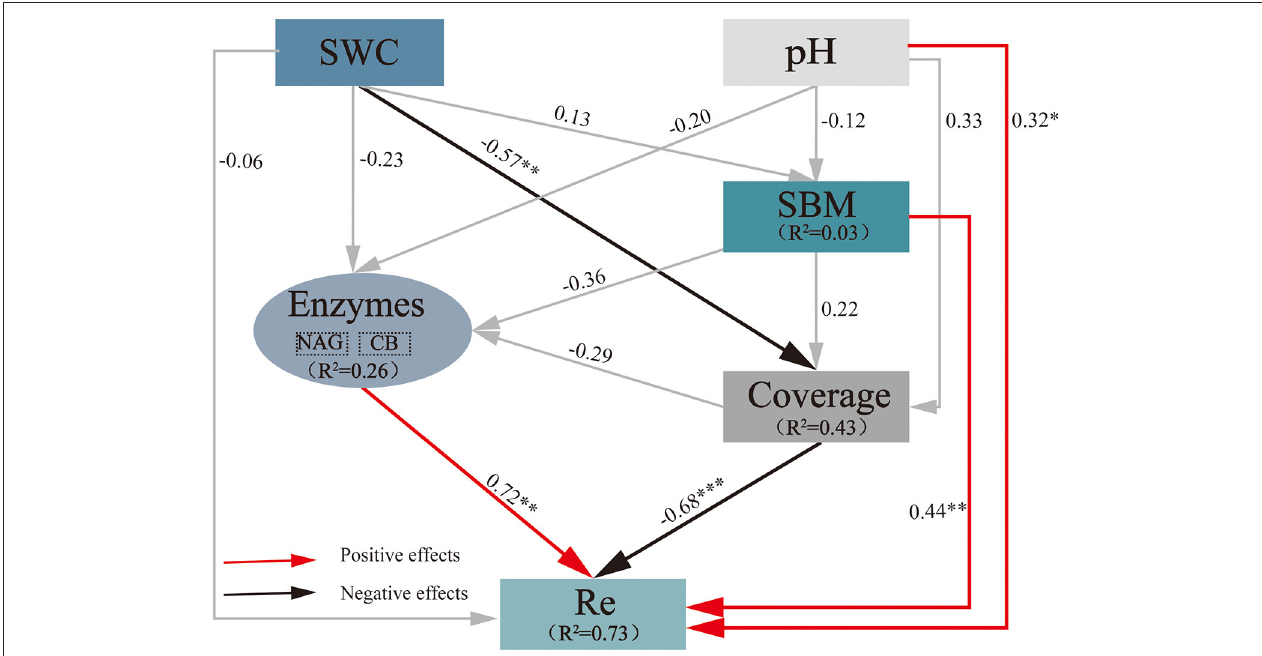
FIGURE 4 | Impacts of selected drivers on Re under extreme drought calculated by the SEM of path analysis based on data collected in 2019. The values on the arrows are normalized path coefficients, and the asterisks after the numbers indicate remarkable correlations (* p < 0.05, ** p < 0.01, and *** p < 0.001). The rectangle R 2 value represents the ratio of variance explained by relationships with other variables. SWC, soil water content; SBM, standing biomass; NAG, β -1,4-N-acetyl-glucosaminidase; Re, ecosystem